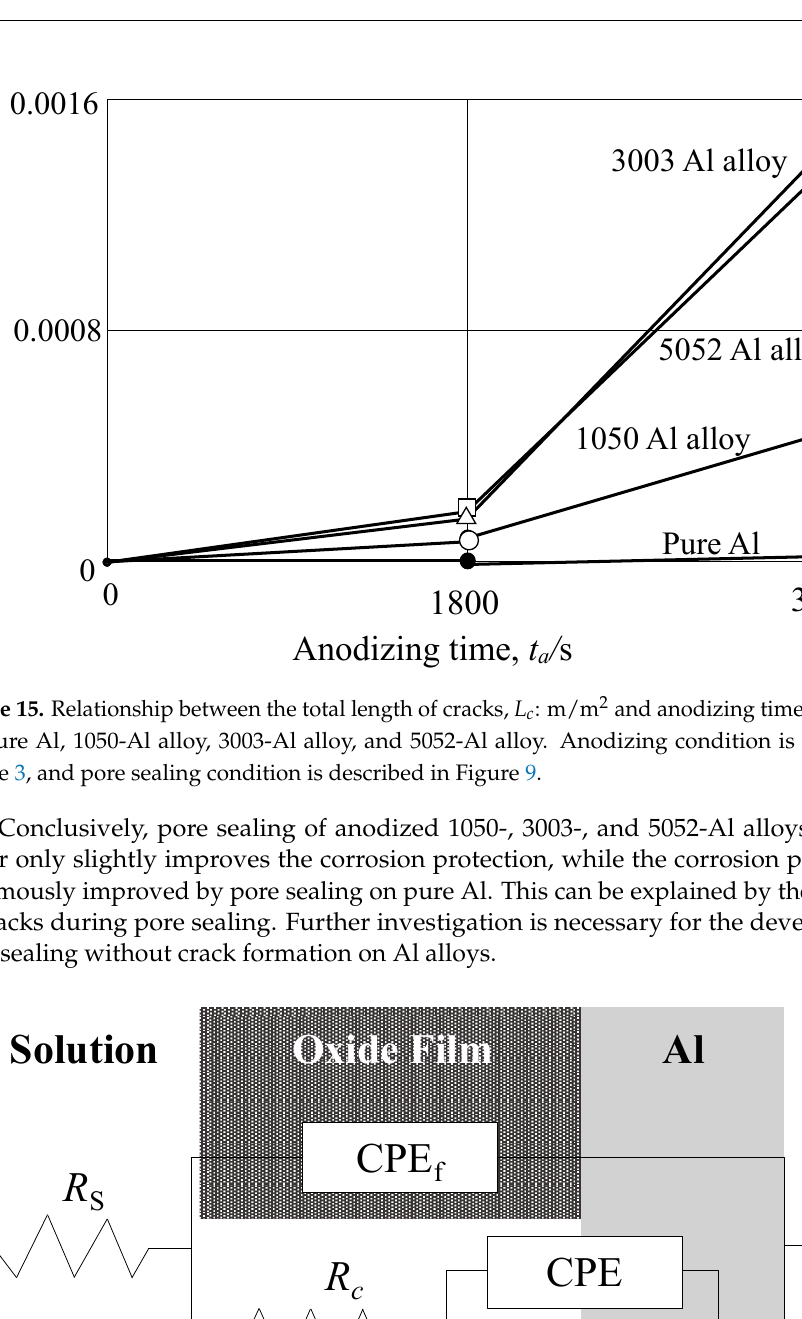
Fig. 9 Figure 16. Equivalent circuit assumed from Figure 12. R s : resistance of bulk solution; R c : solution resistance in cracks; R c : reaction resistance at the bottom of cracks; CPE f : constant phase element of anodic oxide film; CPE : constant phase element at the bottom of cracks